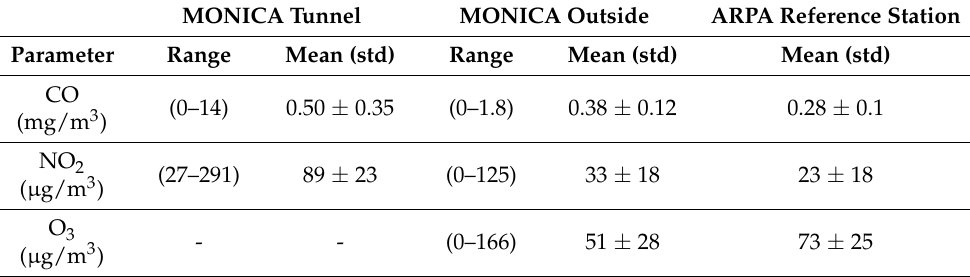
Table 2. CO, NO 2 and O 3 concentrations estimations for MONICA monitors installed inside the tunnel, on the Viaduct San Paolo and by the ARPA reference station in the trimester